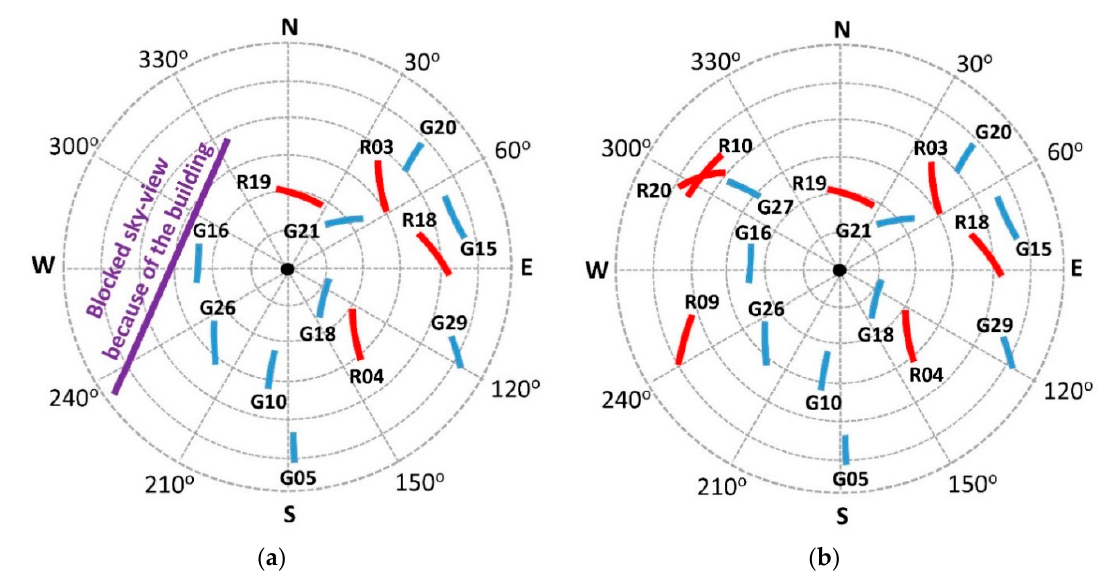
Figure 4. Satellite sky-view at the rover ( a ) and the base station ( b ).